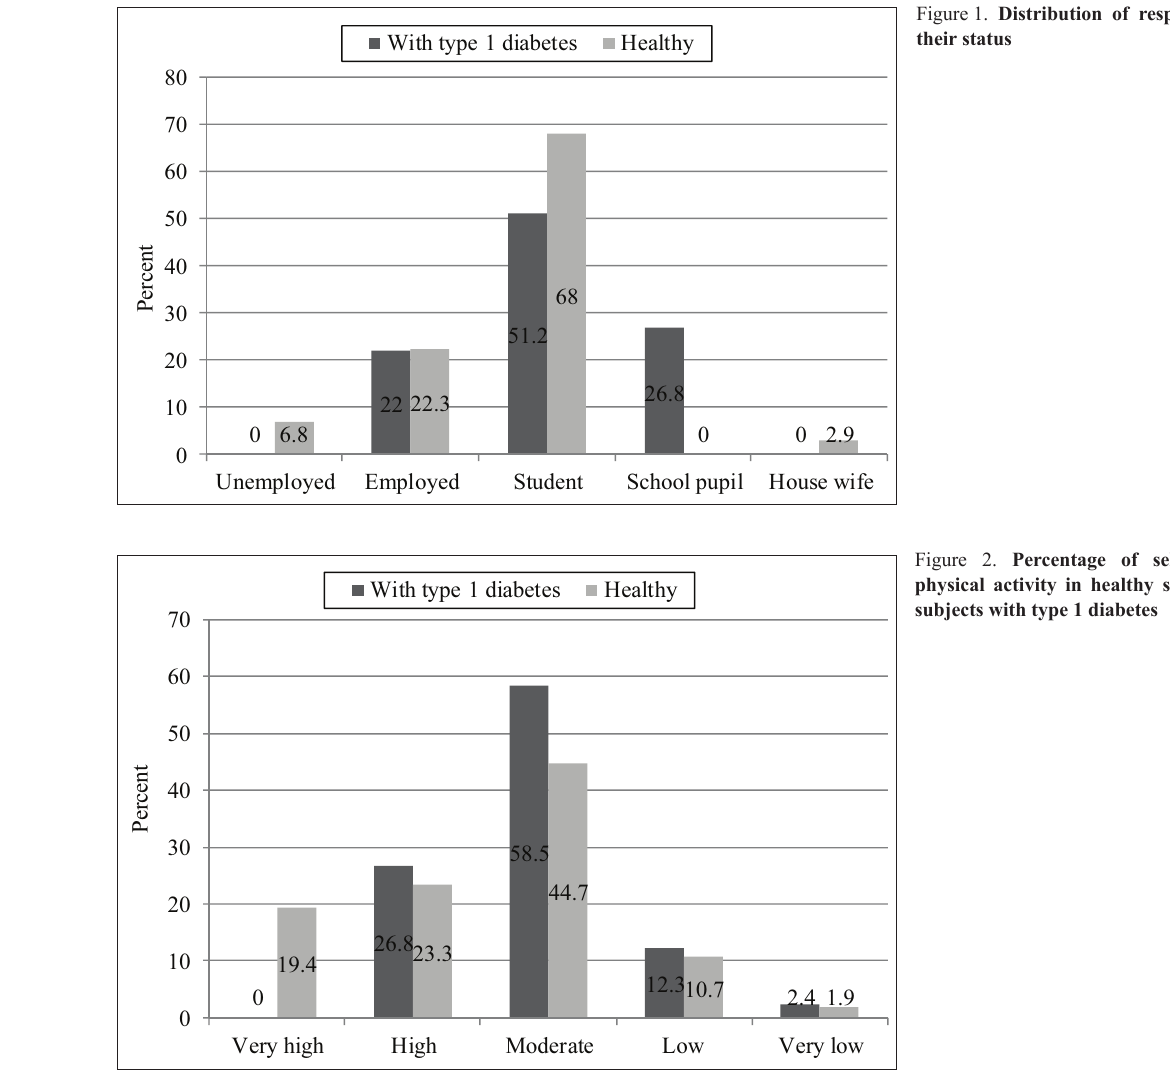
Figure 2. Percentage of self-rating of physical activity in healthy subjects and subjects with